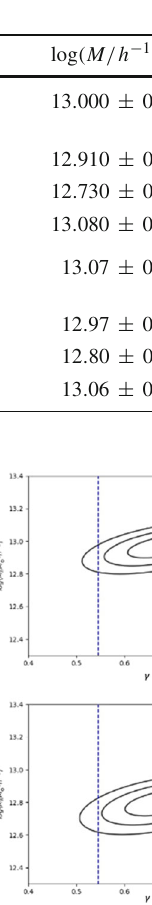
provides the fitted DM halo mass. The remaining columns present the goodness-of-fit statistics χ 2